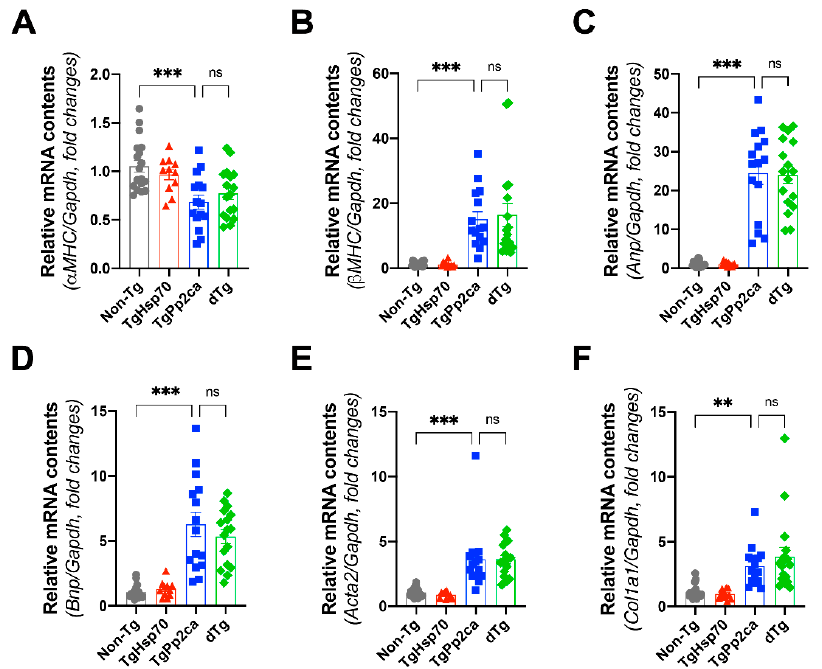
Figure 4. Relative changes in cardiac marker gene expression. ( A , B ) Fetal gene reprogramming: alpha myosin heavy chain ( A ) and beta myosin heavy chain ( B ) are indicators of the hypertrophic response. ( C , D ) Natriuretic peptides: atrial ( C ) and B-type ( D ) natriuretic peptides are indicators of LV wall stress. ( E , F ) Fibrosis markers: smooth muscle alpha-actin ( E ) and type 1 collagen ( F ). HSP70 failed to reverse the changes in marker gene expression. Cohort size, nTg: 19, TgHSP70: 11, TgPP2CA: 15, dTg: 17. ANOVA and LSD post hoc testing were performed. Asterisks indicate statistical significance: **, p < 0.01; ***, p < 0.001; ns, not significant.